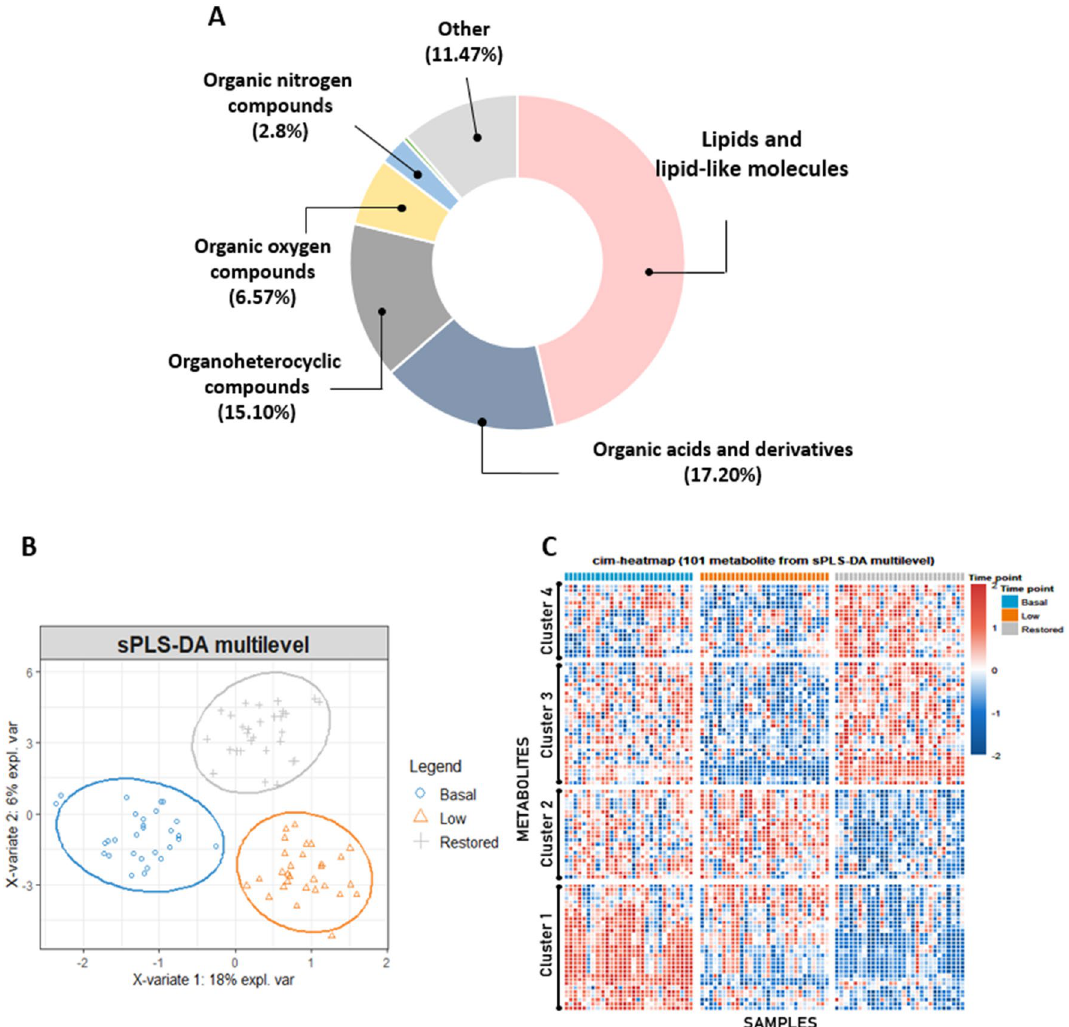
Figure 2. Untargeted metabolomics analysis. ( A ) Chemical class of compounds identified by untargeted metabolomics approach based on UHPLC–HRMS. ( B ) Multilevel multivariate approach: sPLS-DA 2D score plot. The blue, orange, and gray regions represent the 95% confidence area of each group. The blue circles represent the Basal testosterone group, the orange triangles symbolize the Low testosterone group after chemical castration, and the gray crosses represent the Restored testosterone group after TS. ( C ) hierarchical clustering and heatmap based on sPLS-DA data. Four major metabolites clusters were revealed. Most compounds present in clusters 2, 3 and 4 seem to be driven by testosterone since they recovered or tended to recover their levels after TS. Conversely, many metabolites present in cluster 1 appear to be more influenced by LH and FSH expression since their levels did not normalize after